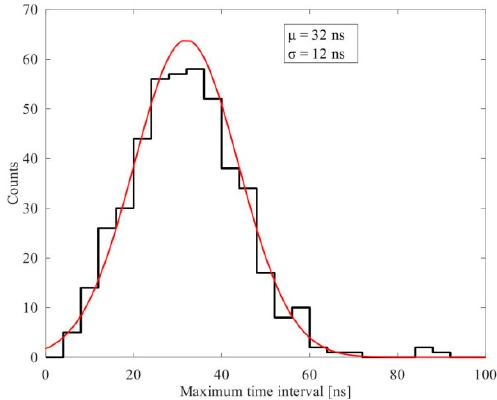
Figure 5. Distribution of 471 coincidence events registered by TOP, BOTTOM, FRONT and REAR